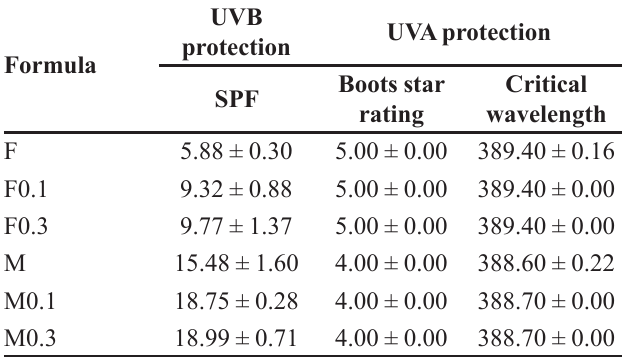
TABLE IV - Sun protection efficacy of the passion fruit makeup